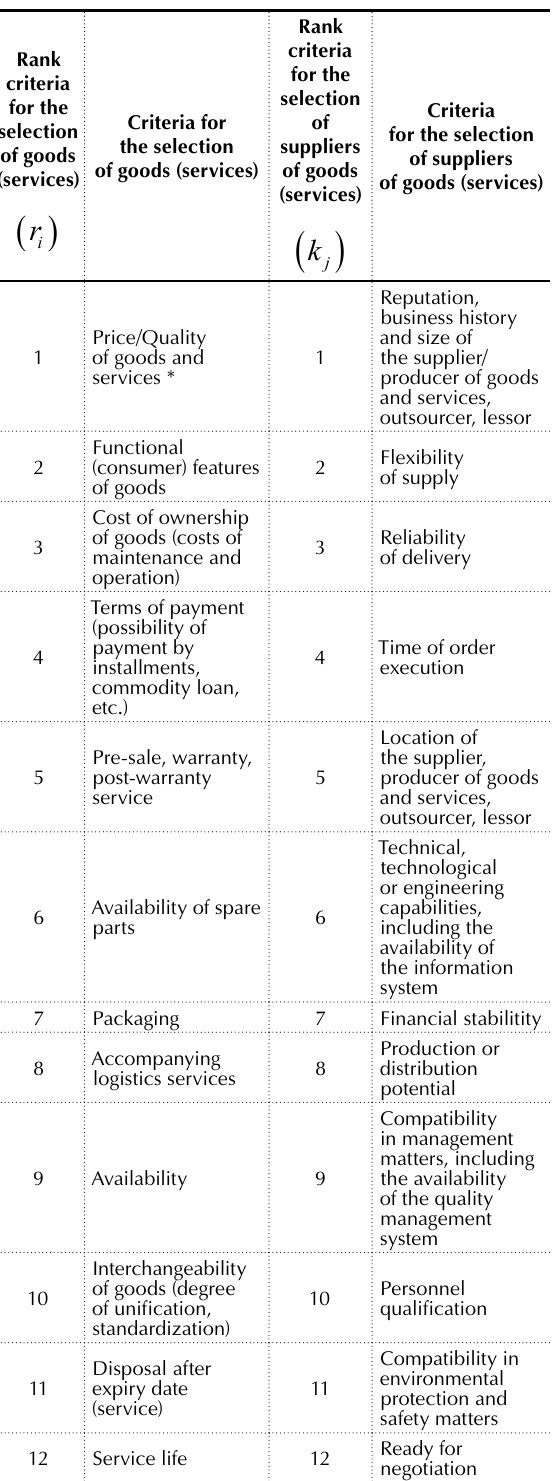
Table 9. Summary matrix of the transformed rank criteria for the selection of goods